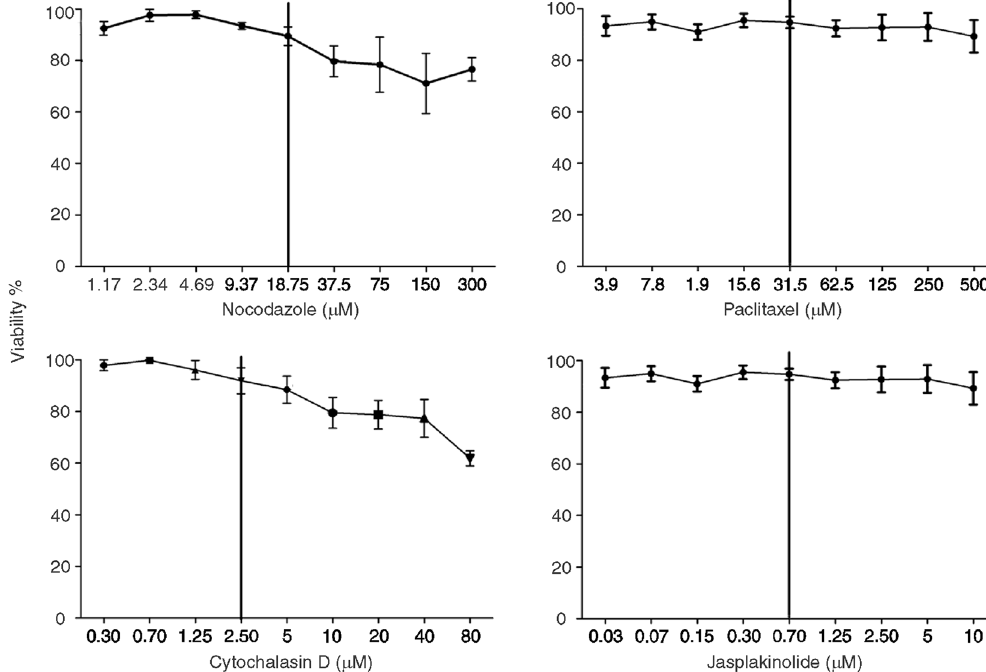
Figure 3. Dose-response curves to NZ, TX, Cyt D, and Jpk in Vero cells. The cellular metabolic activity was measured in Vero cells using the XTT assay. The graphs show % of cellular metabolic activity (mean ± SEM) relative to cell control (triplicates per condition, three independent experiments). The vertical lines represent non-toxic drug concentrations (90% of metabolic activity) chosen for subsequent assays.